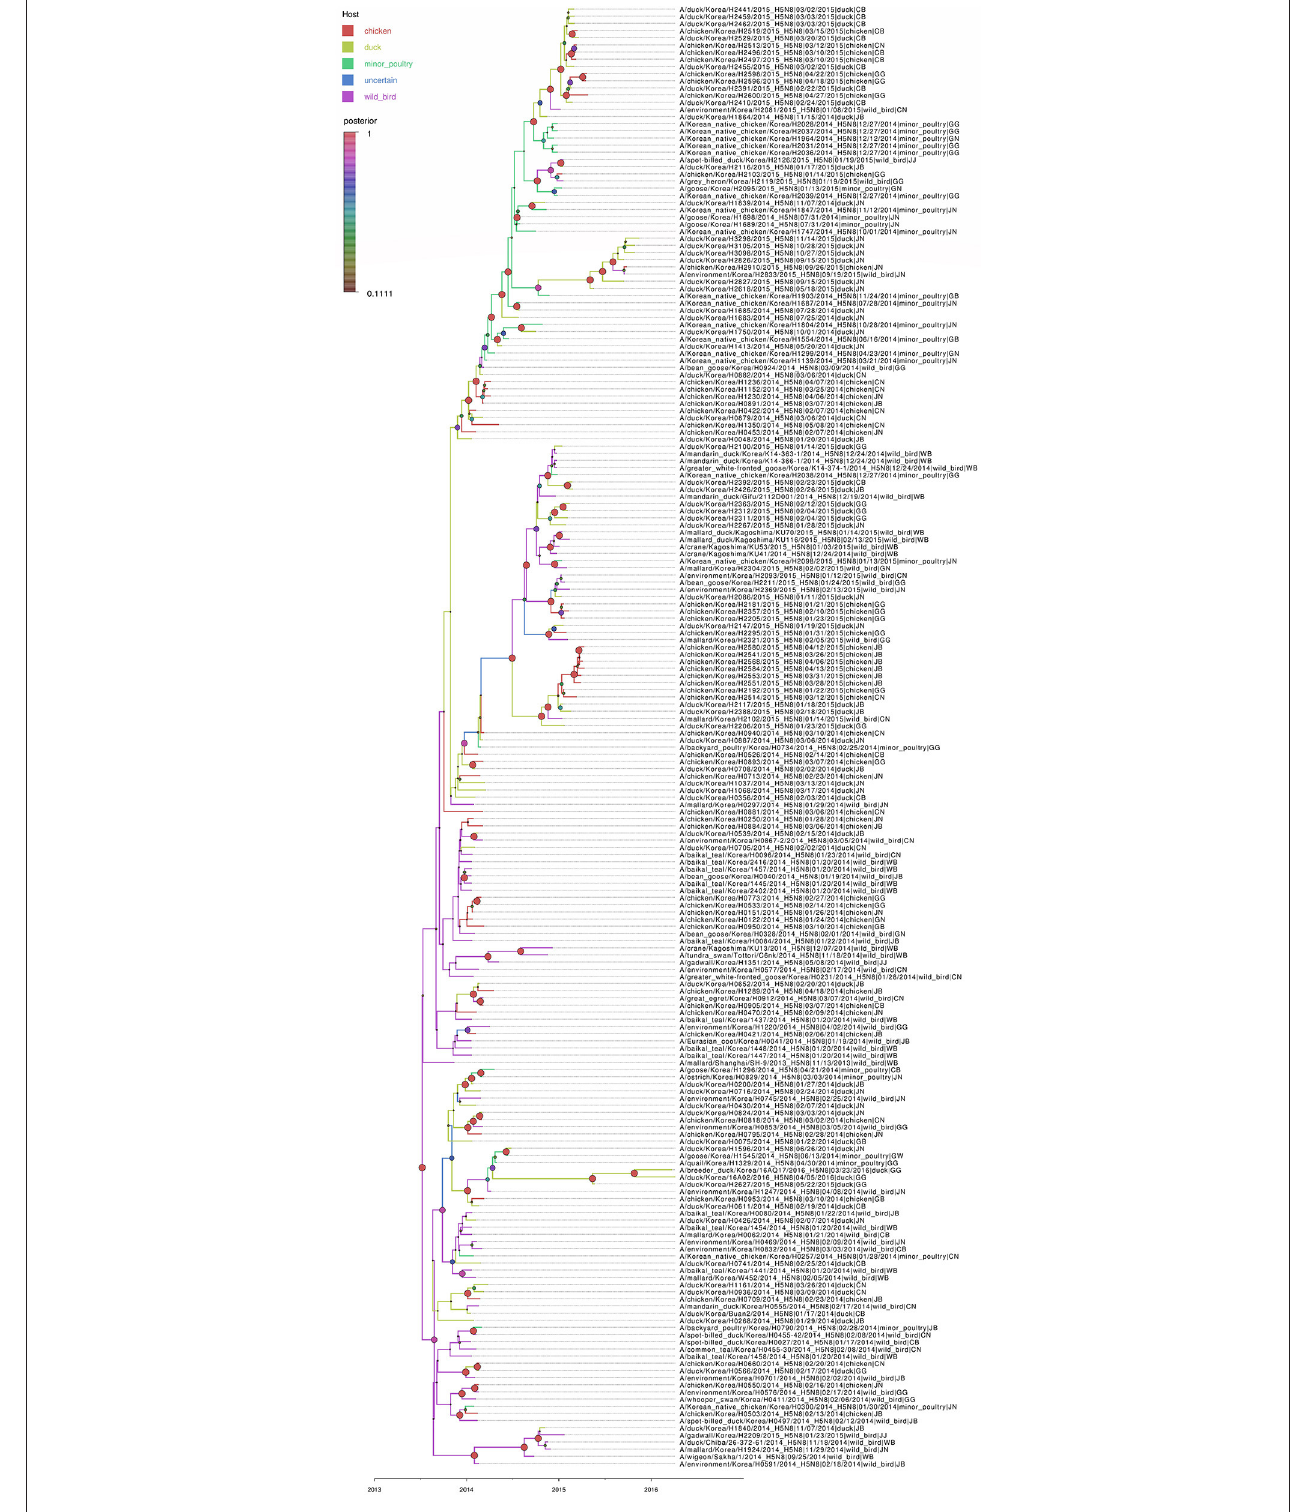
FIGURE 4 | Bayesian phylogenetic tree of the hemagglutinin gene of H5N8 high pathogenicity avian influenza viruses isolated in South Korea during 2014–2016. The host species were defined as discrete states. Posterior probabilities of nodes are indicated by the sizes and colors of the circles.